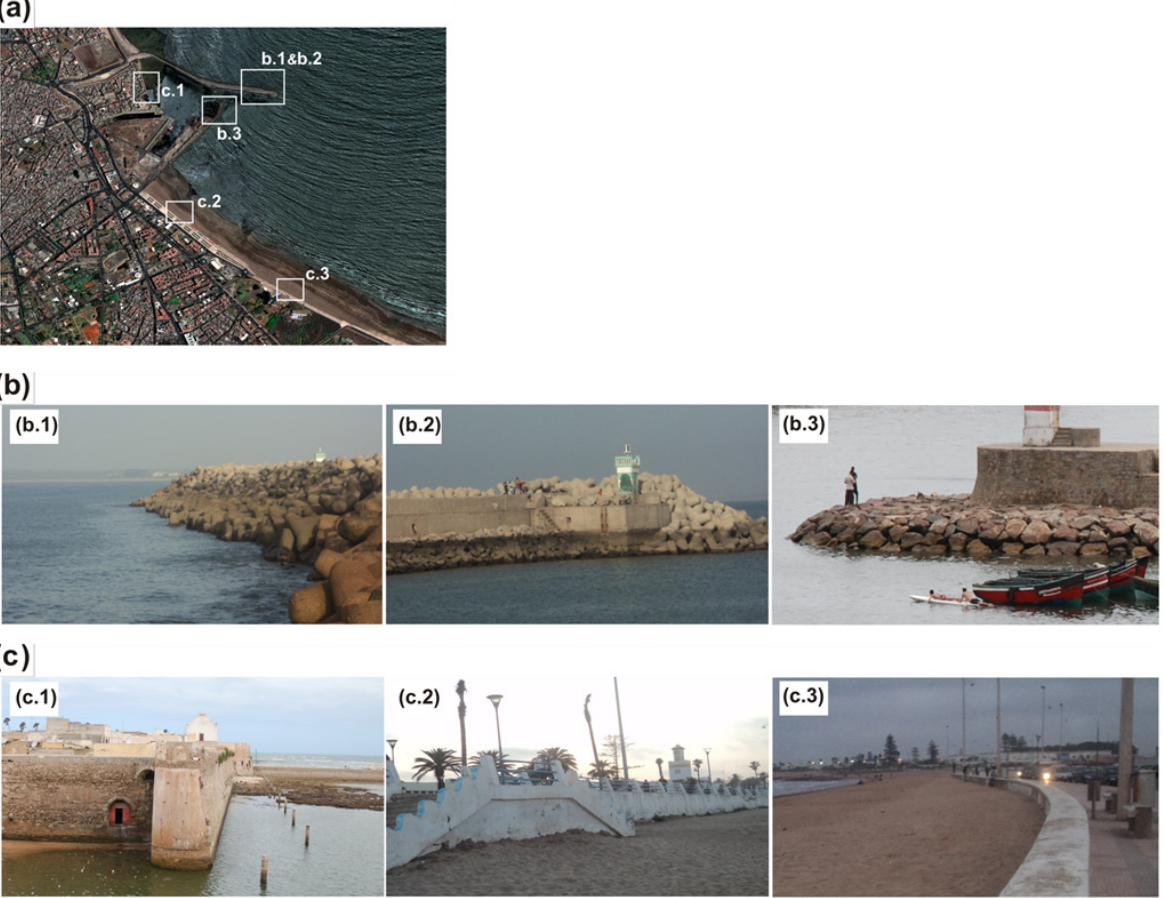
Fig. 3. Coastal sea-defense identification and characteristics in the studied site: (a) location of the visited areas; (b) harbour breakwaters; (c) sea-walls along the El Jadida